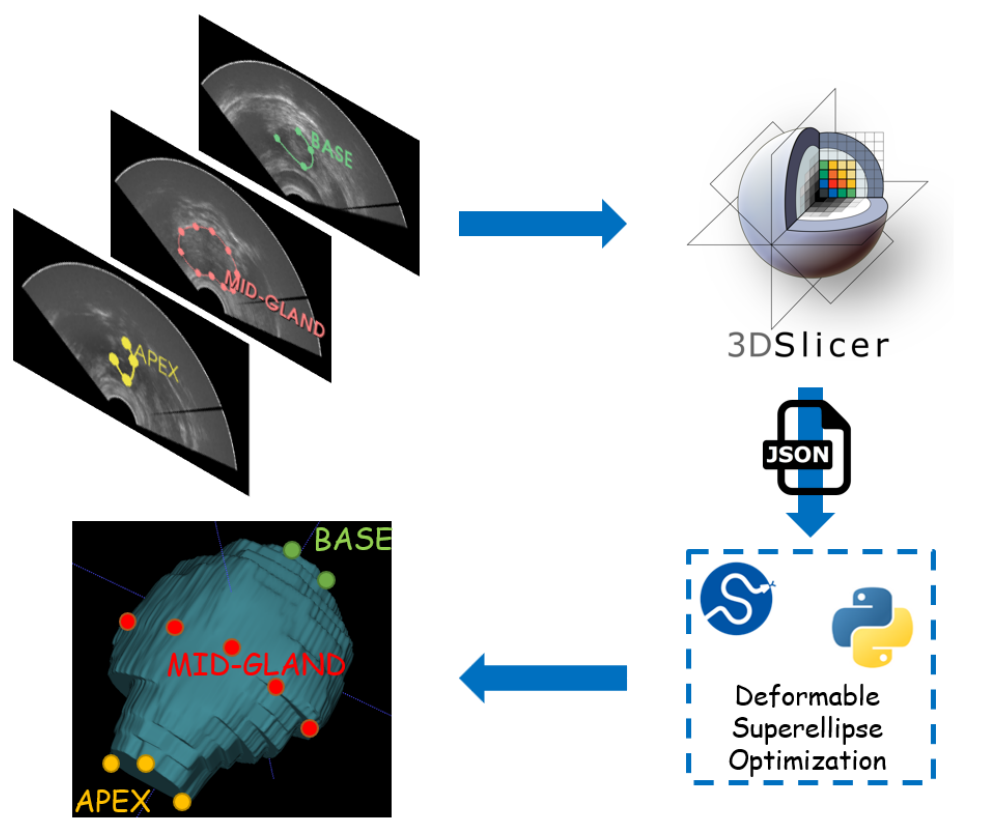
Figure 5. Workflow for TRUS segmentation with the developed methodology. Physicians must annotate some points in the apex, the base, and the mid-gland of the prostate. Then, a JSON file is fed as input to an optimization routine which fits the best 2D superellipse in every annotated slice. Then, a 3D model is built by linearly interpolating 2D models. 3D Slicer has been employed as graphical interface to speed up and ease the